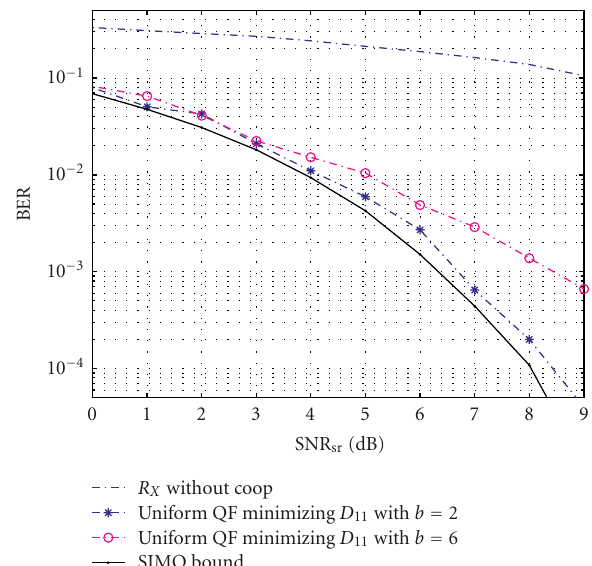
Figure 2: Influence of b on the performance when the uniform QF protocol is used over static channels: raw BER versus SNR sr at the output of the MRC for SNR rd = 10dB with SNR sr = SNR sd +10dB.